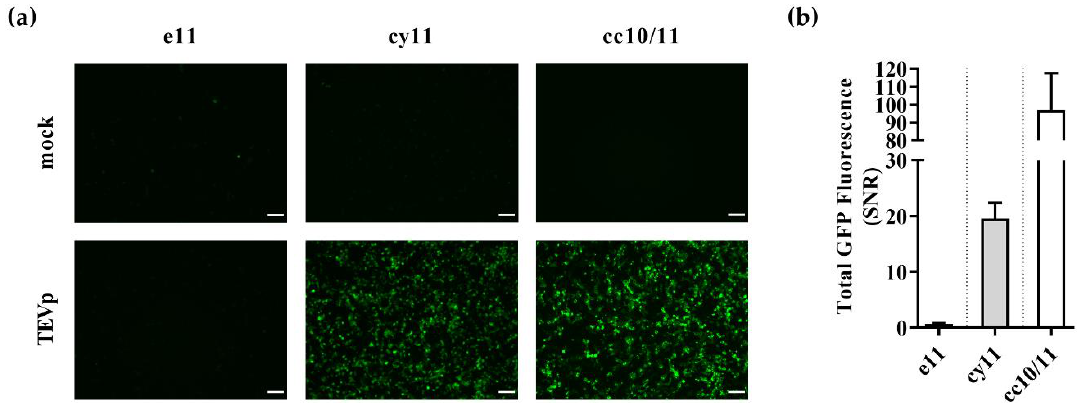
Figure 1. Validation of embedment, cyclization, and coiled-coil sensing strategies for detection of tobacco etch virus proteolytic activity. 293T cells were transiently co-transfected with plasmids coding for either embedded GFP11 (e11), cyclized GFP11 (cy11) or coiled-coil GFP10 and GFP11 (cc10/11) sensors, GFP10-coding plasmid where needed for complementation, and either a mock plasmid or tobacco etch virus protease (TEVp) coding plasmid. After 48 h, ( a ) fluorescence microscopy images were acquired, and ( b ) sensor performance as given by GFP signal-to-noise ratio (SNR) was assessed by flow cytometry. Scale bar = 100 µm. Data shown as mean ± SD of at least three independent experiments.